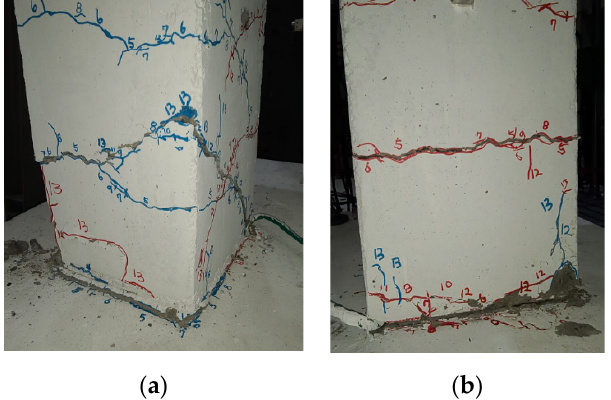
Figure 6. The failure mode of unreinforced S-series specimen. ( a ) front view, ( b ) side view